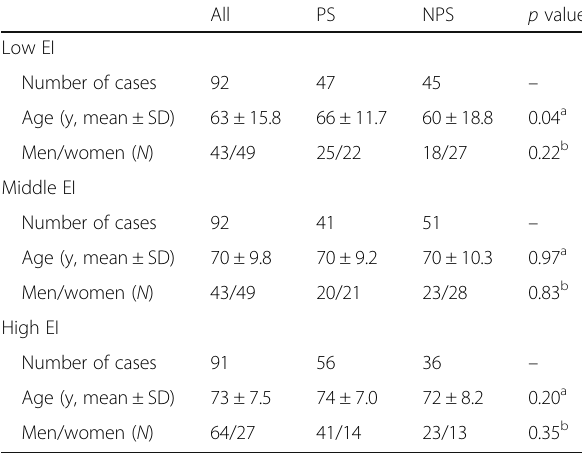
Table 3 Patient characteristics (analysis 2)